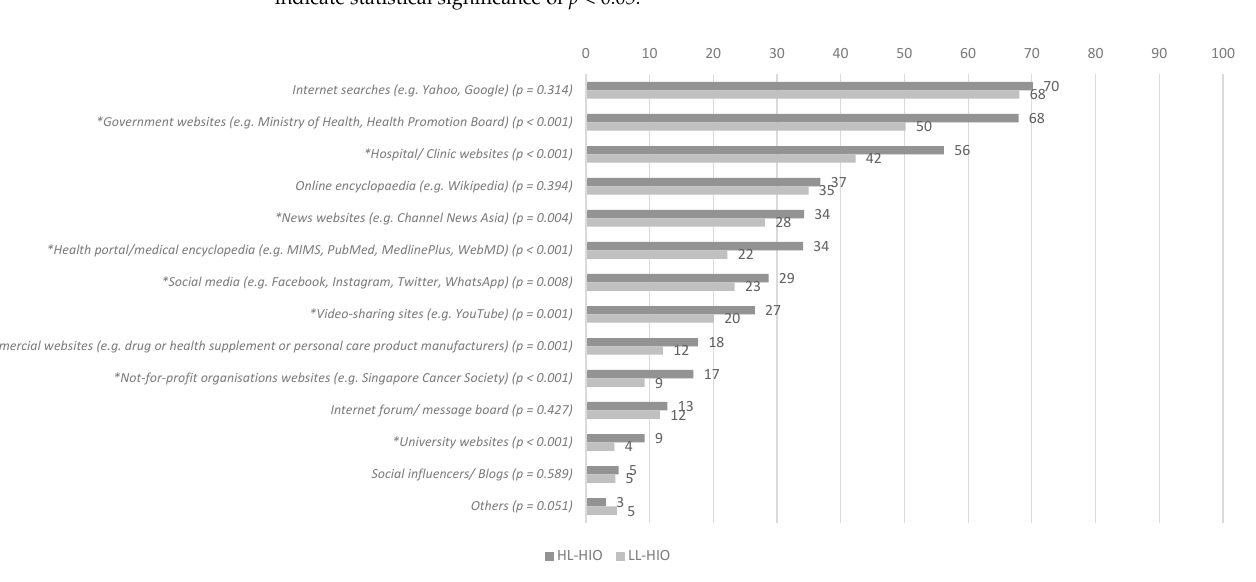
Figure 2. Proportion (%) of 2004 respondents who utilised the following online platforms to seek health information. * indicates a statistically significant ( p < 0.05) difference in proportions of respondents utilising each online platform to seek health information between HL-HIO and LL-HIO groups.